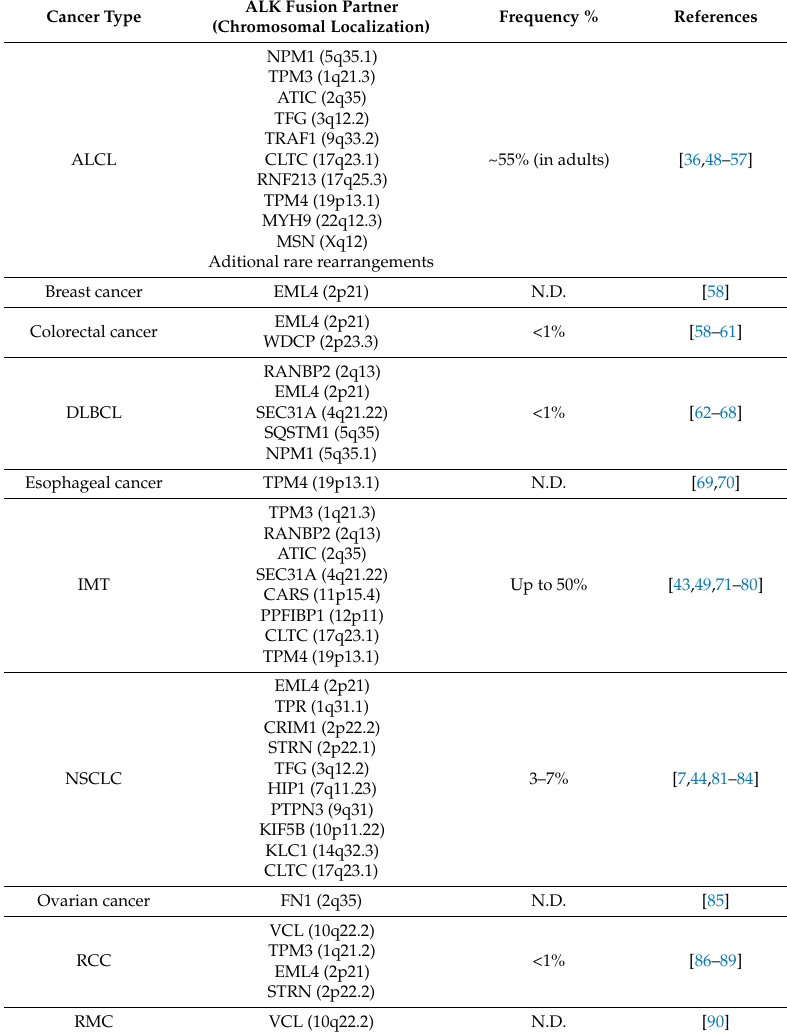
Table 1. ALK rearrangements in human